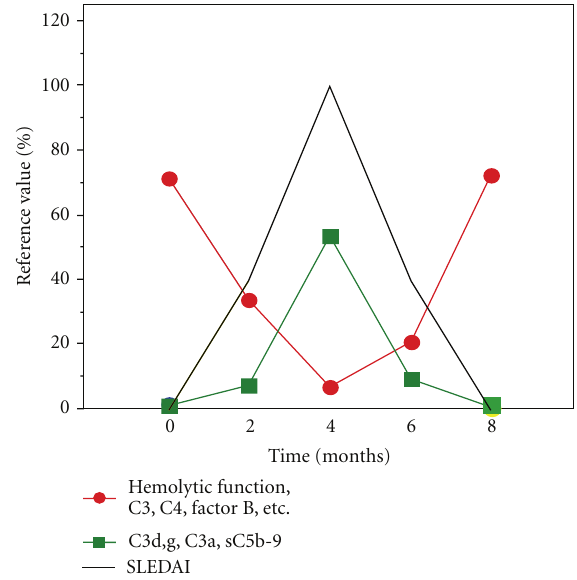
Figure 4: Complement activation and hemolytic function during an SLE exacerbation. C3, C4, factor B, and other components are consumed, leading to a depression in hemolytic function (red line). The resulting activation products, C3d,g, C3a, and sC5b-9 (green line), peak concomitantly with the SLE disease index